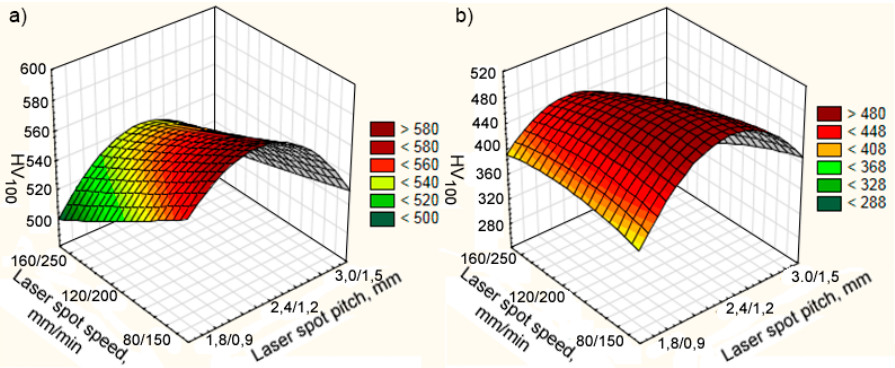
Figure 15. The influence of laser spot speed and pitch of laser deposition on microhardness of components in a single composite layer: ( a ) 12N-01 alloy; ( b ) Fe–Al bronze.